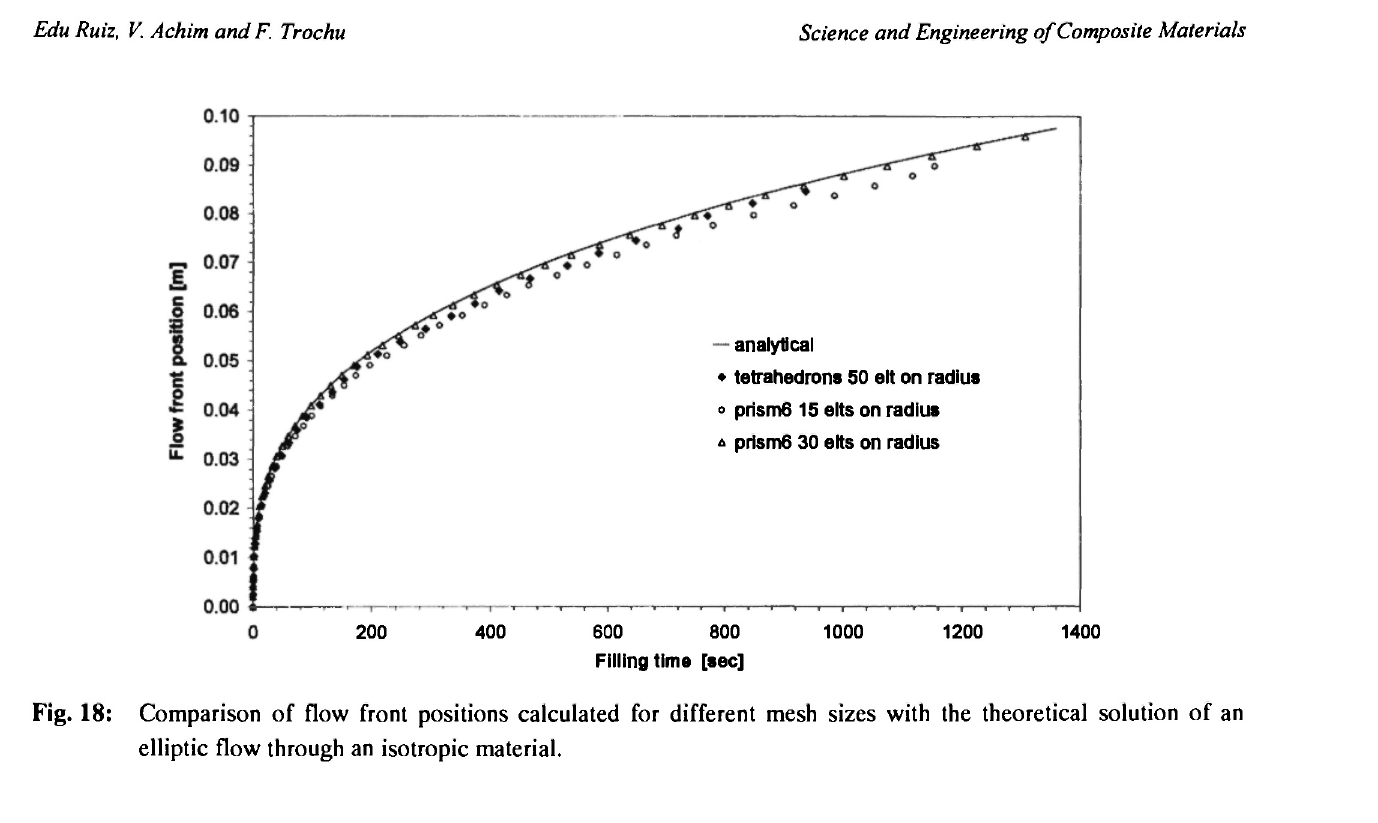
Comparison of flow front positions calculated for different mesh sizes with the theoretical solution of an elliptic flow through an isotropic material.